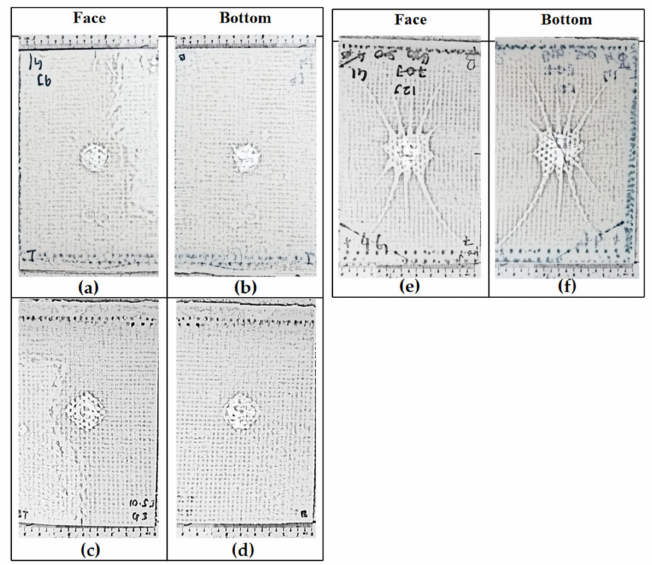
Figure 6. Schematic diagram of the GGGG impacted samples according to the energy level: ( a ) GGGG 9.0 J, ( b ) GGGG 9.0 J, ( c ) GGGG 10.5 J, ( d ) GGGG 10.5 J, ( e ) GGGG 12.0 J and ( f ) GGGG 12.0